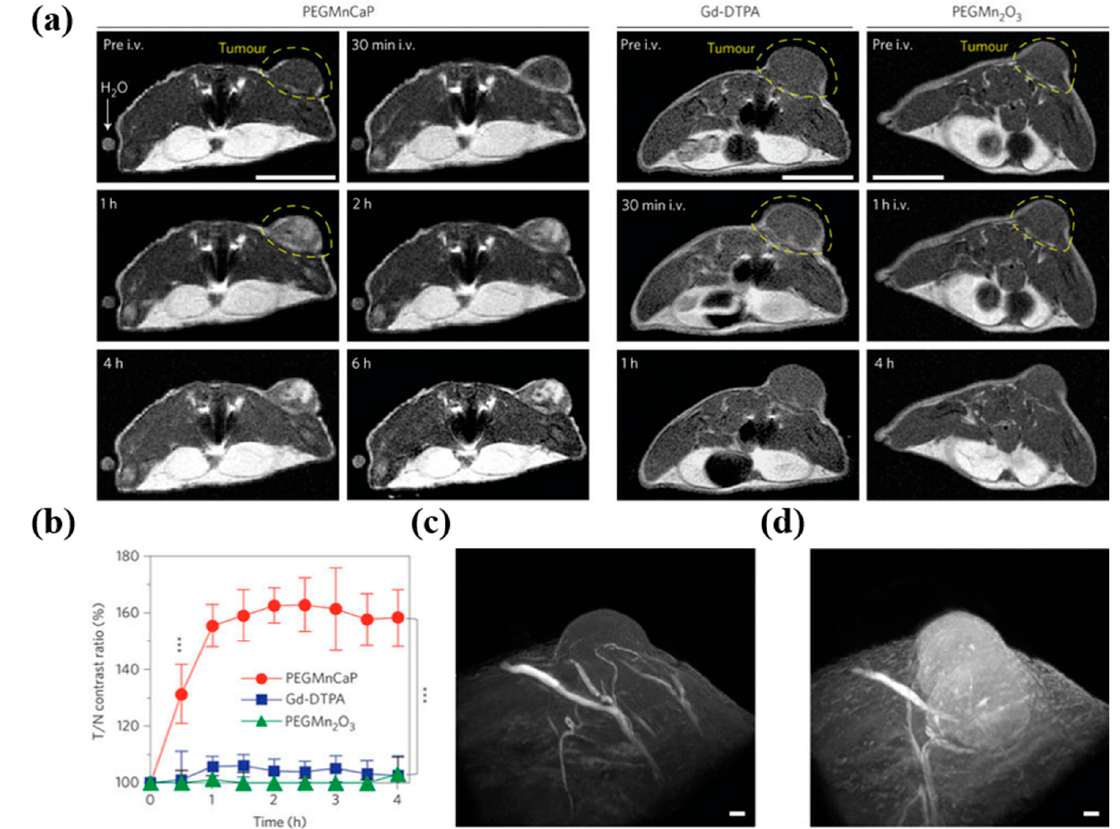
Figure 2. ( a ) In vivo MR images of subcutaneous C26 tumor-bearing mice pre- and post i.v. injection of PEGMnCaP (left), Gd-DTPA (center), and PEGMn 2 O 3 (right) measured with 1 T MRI. Scale bar, 1 cm. ( b ) A comparison of the T / N contrast ratio after administration of PEGMnCaP ( n = 7), Gd-DTPA ( n = 5), and PEGMn 2 O 3 ( n = 3). Three-dimensional MRI of C26 tumors before ( c ) and 1 h after ( d ) the i.v. injection of PEGMnCaP measured with 7 T MRI. Scale bars, 50 µm. Reproduced with permission from Reference [48]. Copyright 2016 Springer Nature.